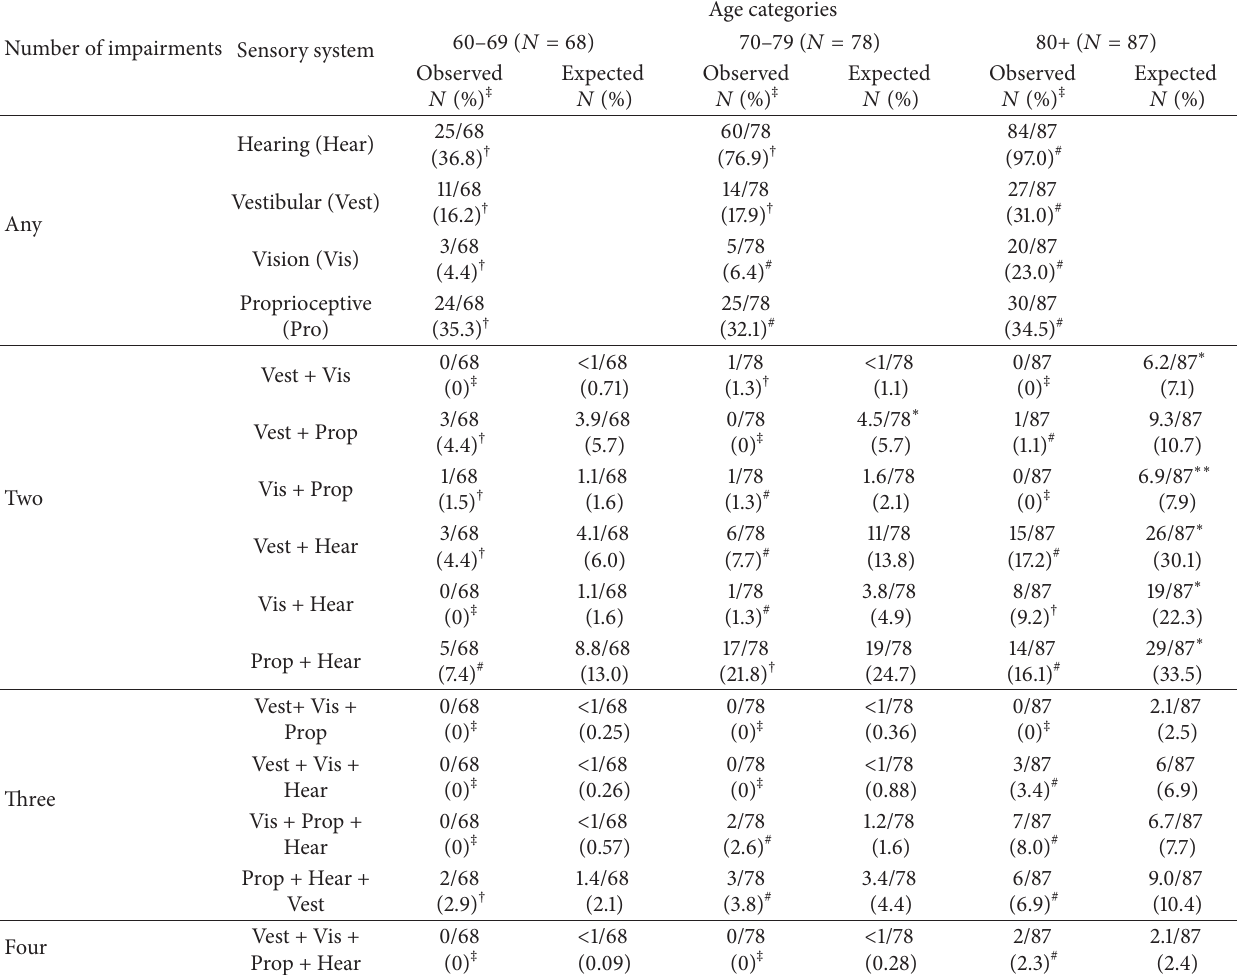
Table 3: Number of impaired sensory systems in study participants by age and Health ABC